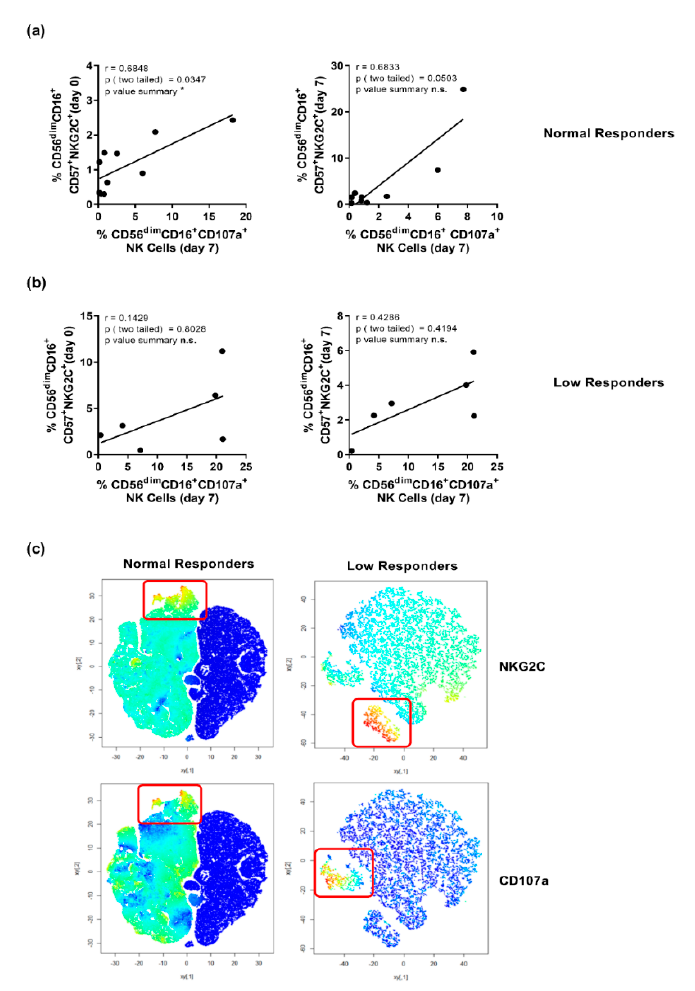
Figure 4. Responders display a correlation of NKG2C with CD107a-expressing NK cells. Flow cytometry derived data from frozen PBMCs isolated from vaccinated individuals classified into responders and non-responders. Correlation of CD57 + NKG2C + CD56 dim CD16 + NK cell frequencies detected prior to vaccination (day 0) or at day 7 post-vaccination with the frequency of CD107a + CD56 dim CD16 + NK cells detected at day 7 post-vaccination depicted for ( a ) responders and ( b ) non-responders. The black line depicts the linear regression; calculations were performed by Spearman correlation analysis. Asterisks indicate significant correlations according to * p ≤ 0.05; n.s. = not significant. ( c ) T-distributed SNE ( t SNE) analysis of flow cytometry data derived from normal and low responders before and at day 7 post-vaccination. Cells displaying a high ( red ) or low ( blue ) expression density of NKG2C (upper panel) and CD107a (lower panel) are depicted for responders ( left ) and non-responders ( right ).